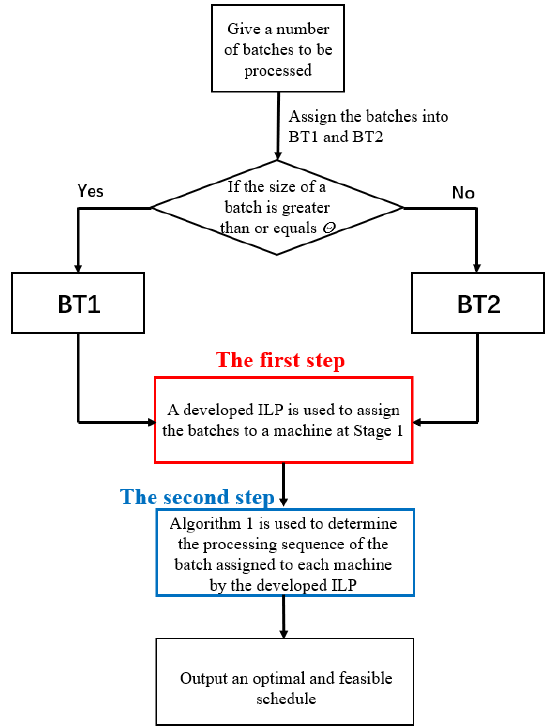
Figure 4. The flowchart of the proposed two-step solution method.